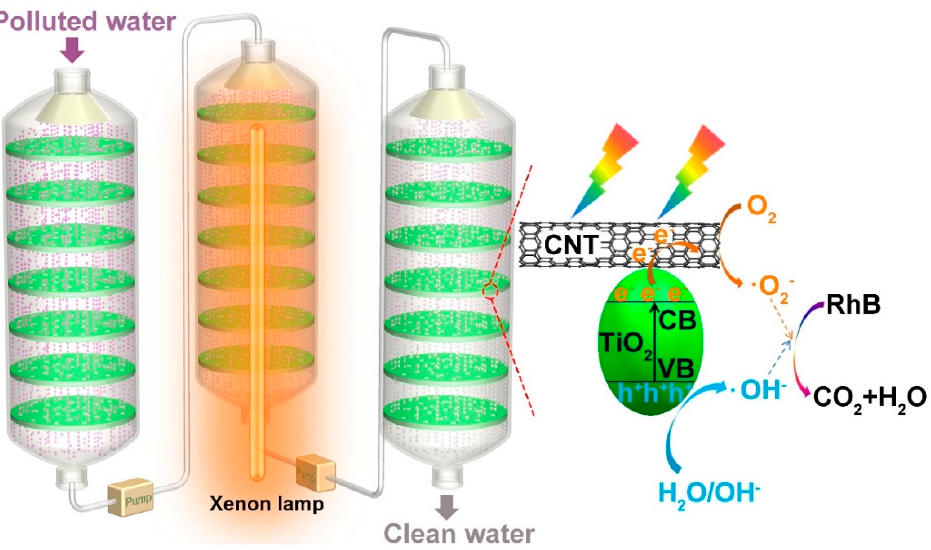
Figure 5. Schematic diagram of the continuous-flow photodegradation and photocatalytic degradation mechanism of RhB on SCTF-2.5.